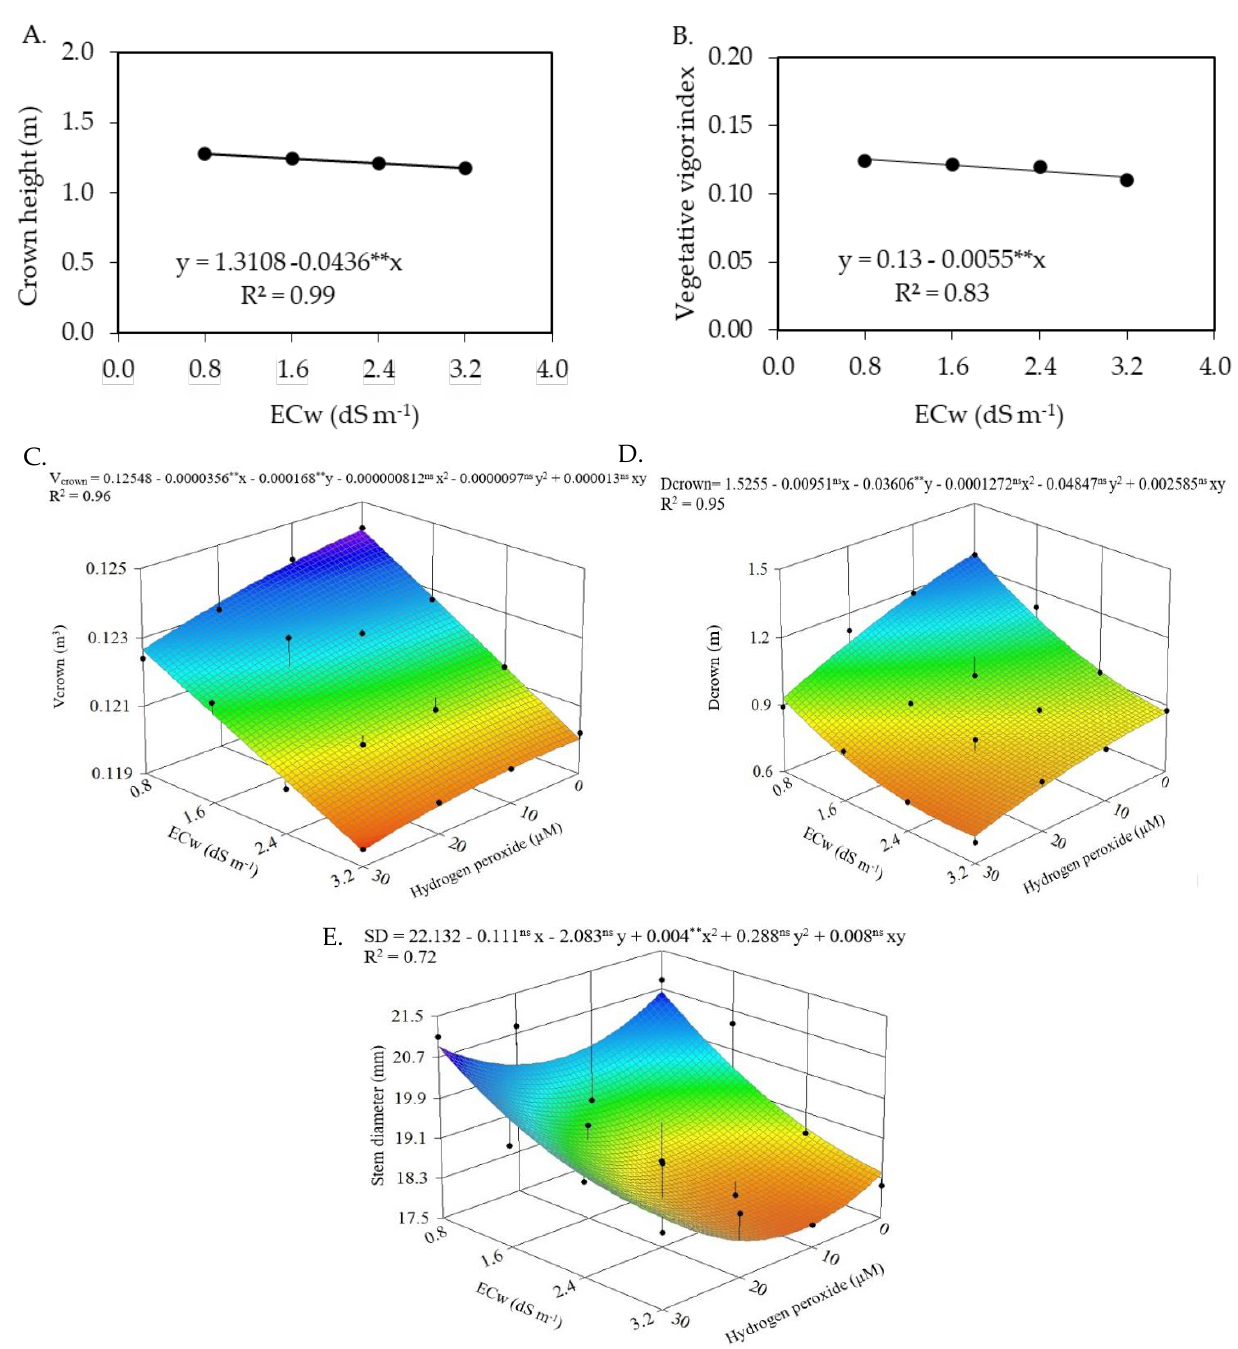
Figure 4. Crown height (Hcrown) ( A ) and vegetative vigor index (VVI) ( B ) of soursop plants cv. Morada Nova as a function of the irrigation water salinity (ECw), and crown volume (Vcrown) ( C ), crown diameter (Dcrown) ( D ), and stem diameter (SD) ( E ), as a function of the interaction between the salinity of irrigation water (ECw) and hydrogen peroxide concentrations at 210 days after transplantation. ns and ** are, respectively, not significant and significant at p ≤ 0.01 by the F-test. x and y correspond to ECw and hydrogen peroxide (H 2 O 2 ) concentrations, respectively.